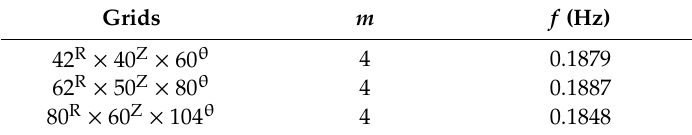
Table 2. Mesh dependence tests at Re c = 9.4 × 10 2 , Re s = − 1.2 × 10 3 , and Re T = 2 × 10 4 .